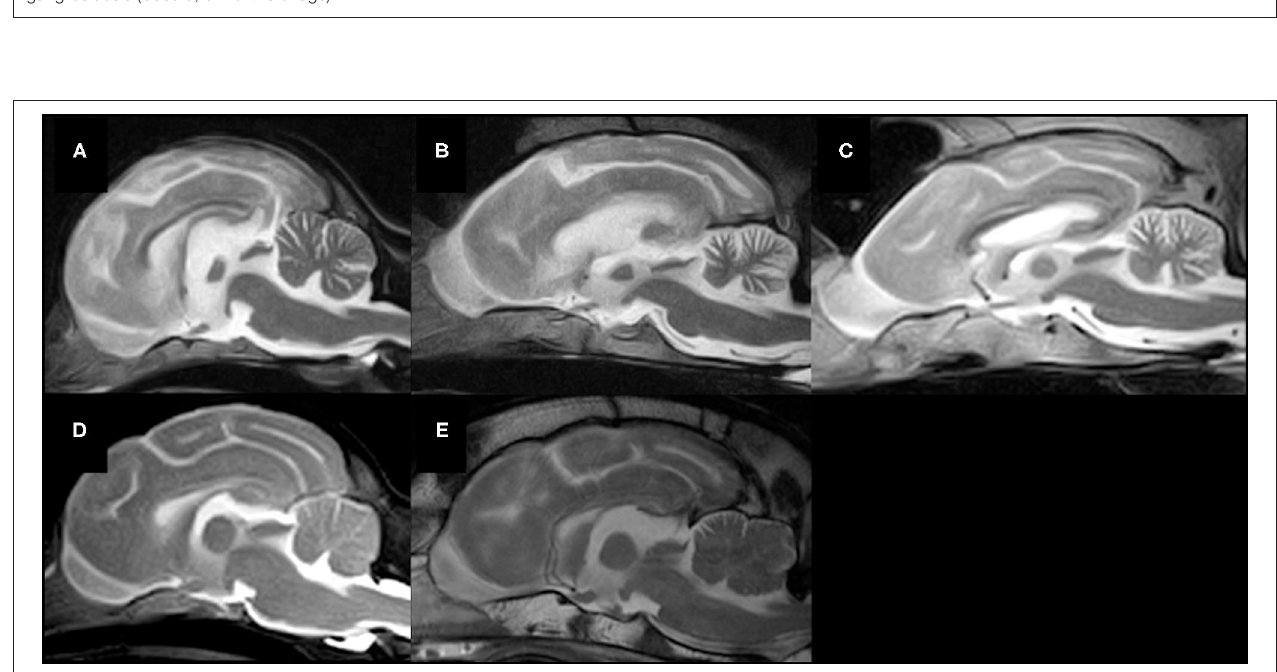
FIGURE 3 | Mid-sagittal T2-weighted MR images of five lysosomal storage diseases. (A) A Chihuahua with NCL (Case 1, 19 months of age), (B) a Border Collie with NCL (Case 3, 16 months of age), (C) a Shikoku Inu with NCL (Case 5, 68 months of age), (D) a Toy Poodle with GM2 gangliosidosis variant 0 (Sandhoff disease) (Case 7, 21 months of age), (E) a Shiba Inu with GM1 gangliosidosis (Case 8, 11 months of age). Atrophy of the whole brain, including the cerebellum, is observed in all cases.